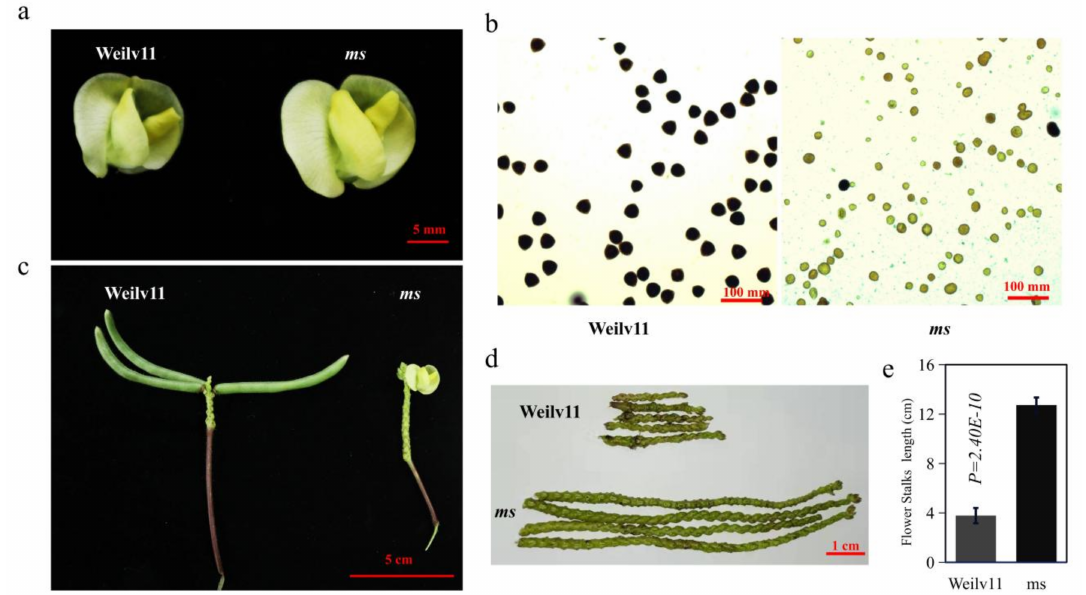
Figure 1. Phenotypic analysis of the ms mutant: ( a ) vegetative growth stage at 2 DAF; ( b ) I 2 -KI staining of Weilyu 11 and ms mature pollen; ( c ) reproductive growth stage at 20 DAF; ( d ) the length of flower stalks of Weilyu 11 and ms at 45 DAF; ( e ) statistics on the flower stalks of Weilyu 11 and ms. In ( c ), bar = 5 mm; in ( b ), bar = 100 mm; in ( c ), bar = 5 cm; in ( d ), bar = 1 cm. Student’s t -test statistical analyses were utilized to look for differences in the length of flower stalks with p < 0.05 set as statistically